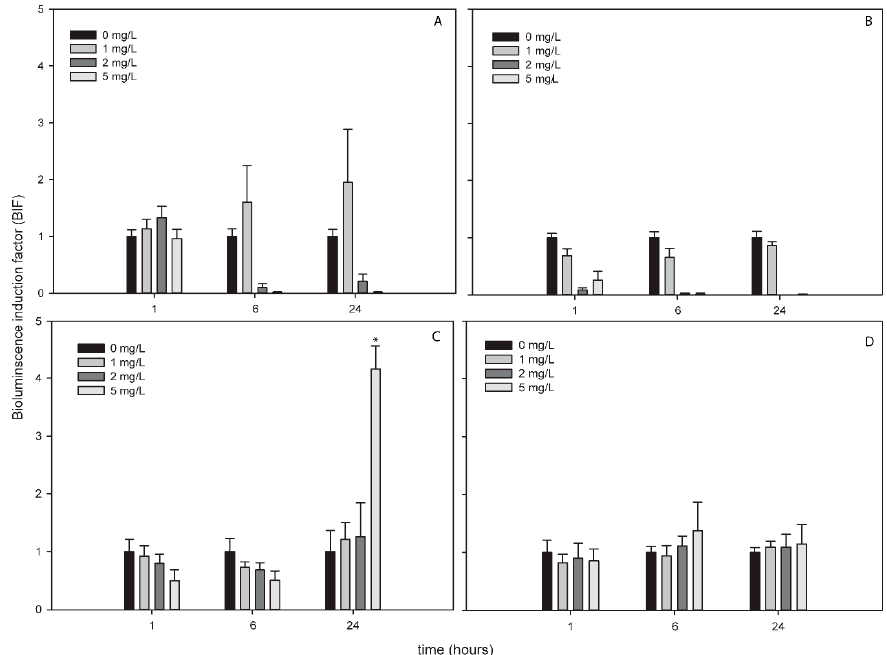
Figure 4. Bioluminescence induction of ROS-detecting Nostoc sp. PCC7120 bioreporters exposed to 0, 1, 2 and 5 mg/L of ZnNPs after 1, 6 and 24 h of exposure. ( A ) Nostoc sp. PCC7120 pBG2154, ( B ) Nostoc sp. PCC7120 pBG2165, ( C ) Nostoc sp. PCC7120 pBG2172 and ( D ) Nostoc sp. PCC7120 pBG2173. The